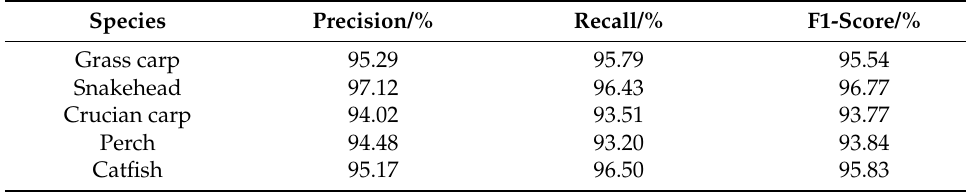
Table 7. Recognition results for different species of freshwater